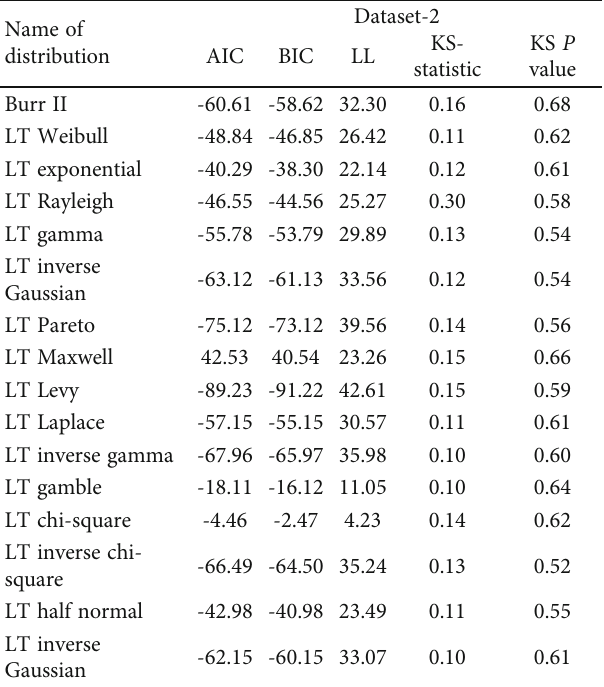
Table 23: Comparison of BT-IID with class of GGIDs using dataset-2.